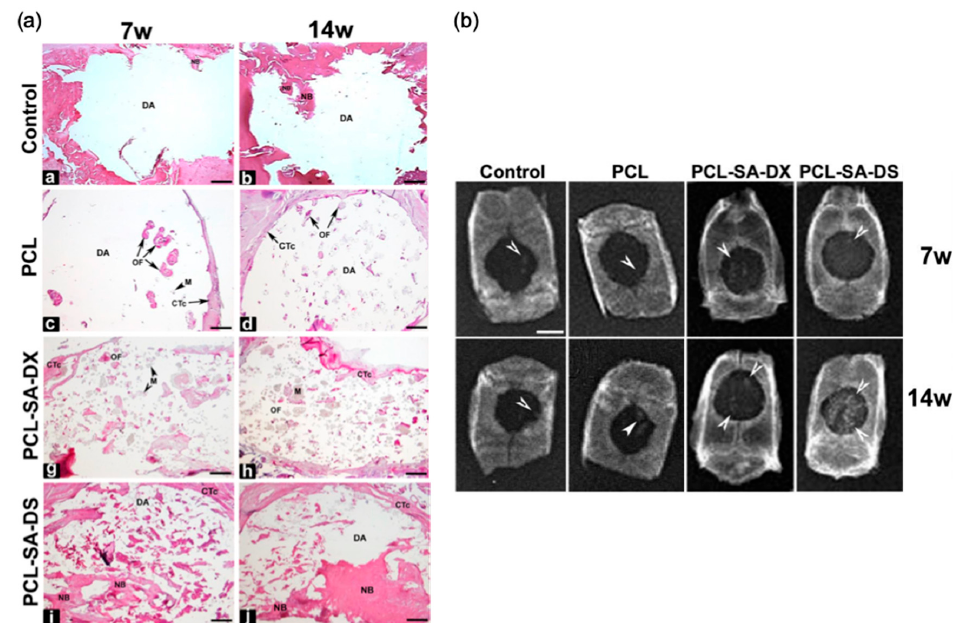
Figure 10. ( a ) Rat crania histological analysis after 7 (7w) and 14 weeks (14w) post-implantation of PCL-based scaffold containing dexamethasone both in the base (DX) and phosphate (DS) forms. Areas of new bone formation are clearly appreciated in PCL-SA-DS formulations. Notation: CTc: connective tissue capsule, DA: defect area, M: material, NB: newly formed bone, OF: ossification foci. ( b ) Accompanying X-ray radiographies of former rat crania. White arrows highlight areas of radiological density compatible with bone neoformation, being remarkably increased for those scaffolds containing dexamethasone. Scale bars: ( a ) 1 mm and ( b ) 4 mm. Figures reprinted from Journal of CO2